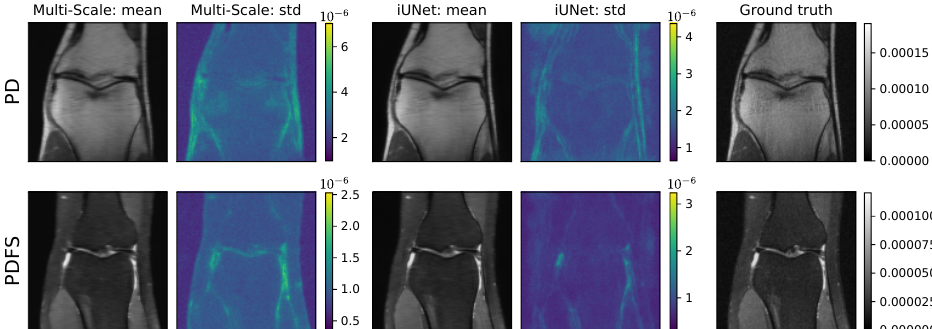
Figure 9. Cond. mean and point-wise standard deviation for the best-performing multi-scale architecture and iUNet on the fastMRI data. Both networks use the radial base distribution and no additional training noise, and the iUNet is trained with conditional loss.